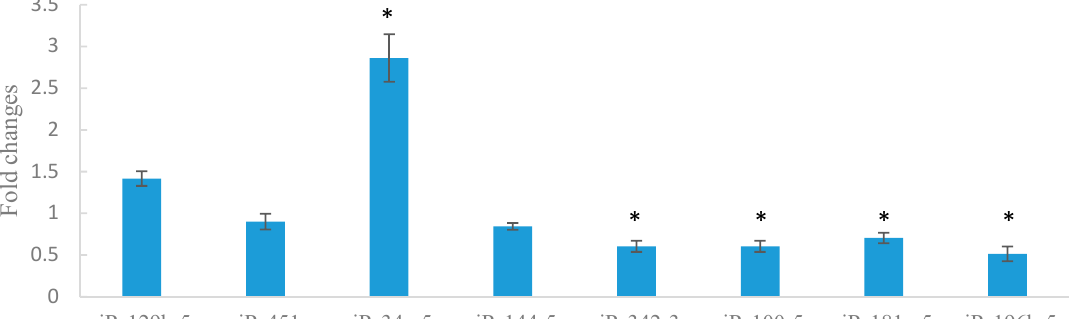
Figure 4. Signi fi cantly di ff erential expression of miRNAs in Lin − c-Kit+ cells of mice exposed to benzene compared with the control group. The data are presented as the mean ± SD. n = 4 for each group.